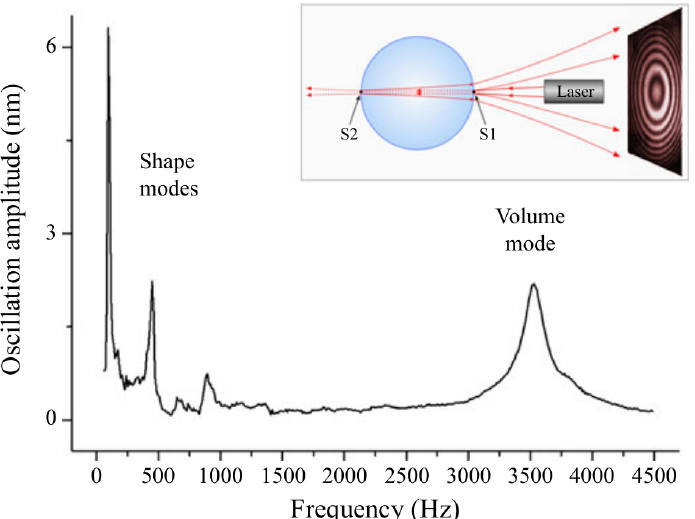
Figure 19. Frequency spectrum of a single bubble with a 0.85mm radius in water obtained using an optical interferometry technique. The spectrum reveals the presence of (non-spherical) shape oscillation modes in the frequency range from approximately 100Hz to 1.5kHz and of a volume oscillation (spherical) mode at approximately 3.55kHz. The inset shows schematically the detection principle, where a laser beam focused on a bubble undergoes reflections at the curved interfaces (points S1 and S2) generating an interference pattern in the direction opposite to that of the incident laser beam. Reproduced with permission from [221]. Copyright 2022 Cambridge University